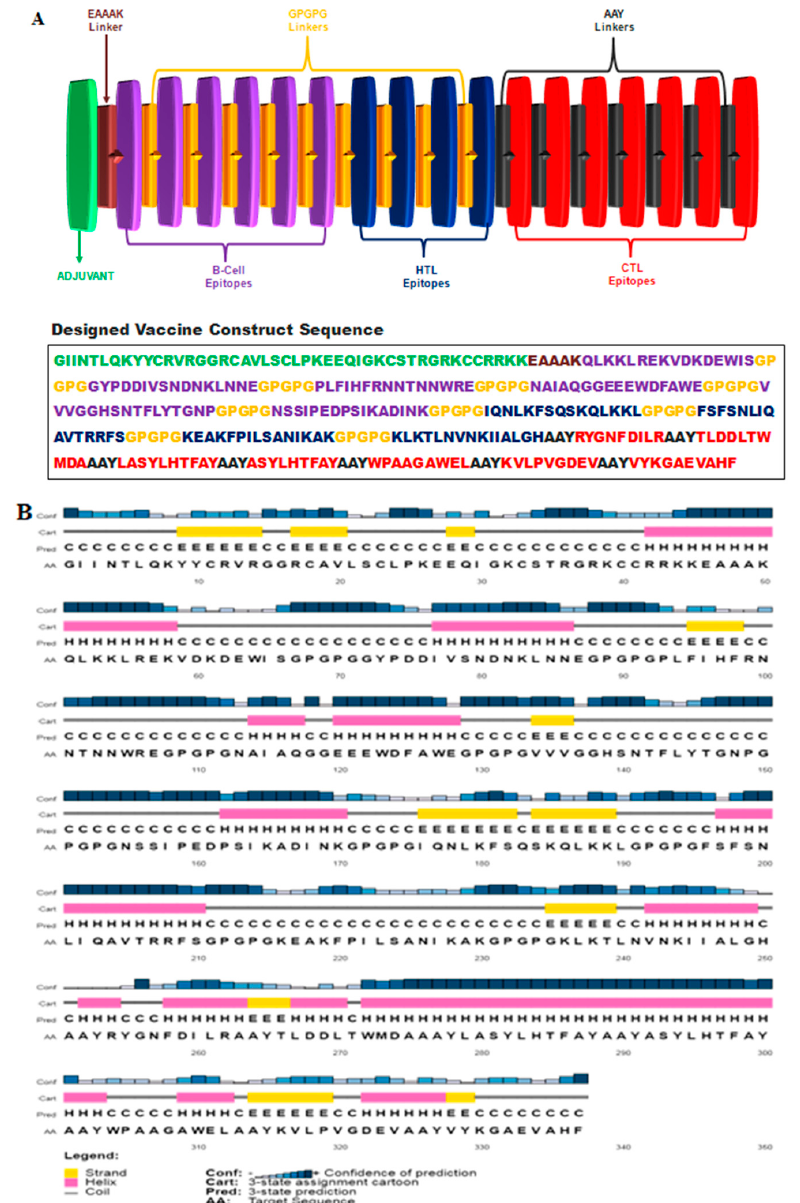
Figure 2. ( A ) Depicting designed multi-epitope vaccine construct and amino acid sequence. B cell and HTL epitopes were linked using GPGPG linkers, CTL epitopes were linked using AAY linkers and adjuvant was connected to N-terminal with EAAAK linker. ( B ) Predicted secondary structure of the epitope vaccine showing 37% alpha-helix, 14% beta-strand and 49% coils.